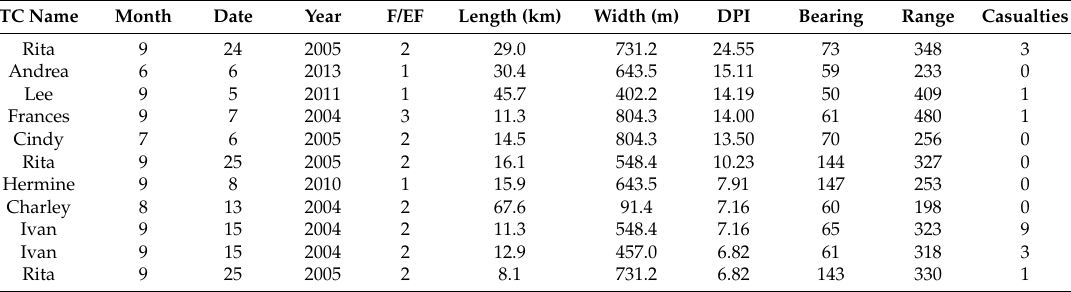
Figure 4. Frequency distribution of the DPI of 1285 TC tornadoes. The Y-axis is logarithmic. Table 13. Top ten tornadoes (and ties) by DPI.